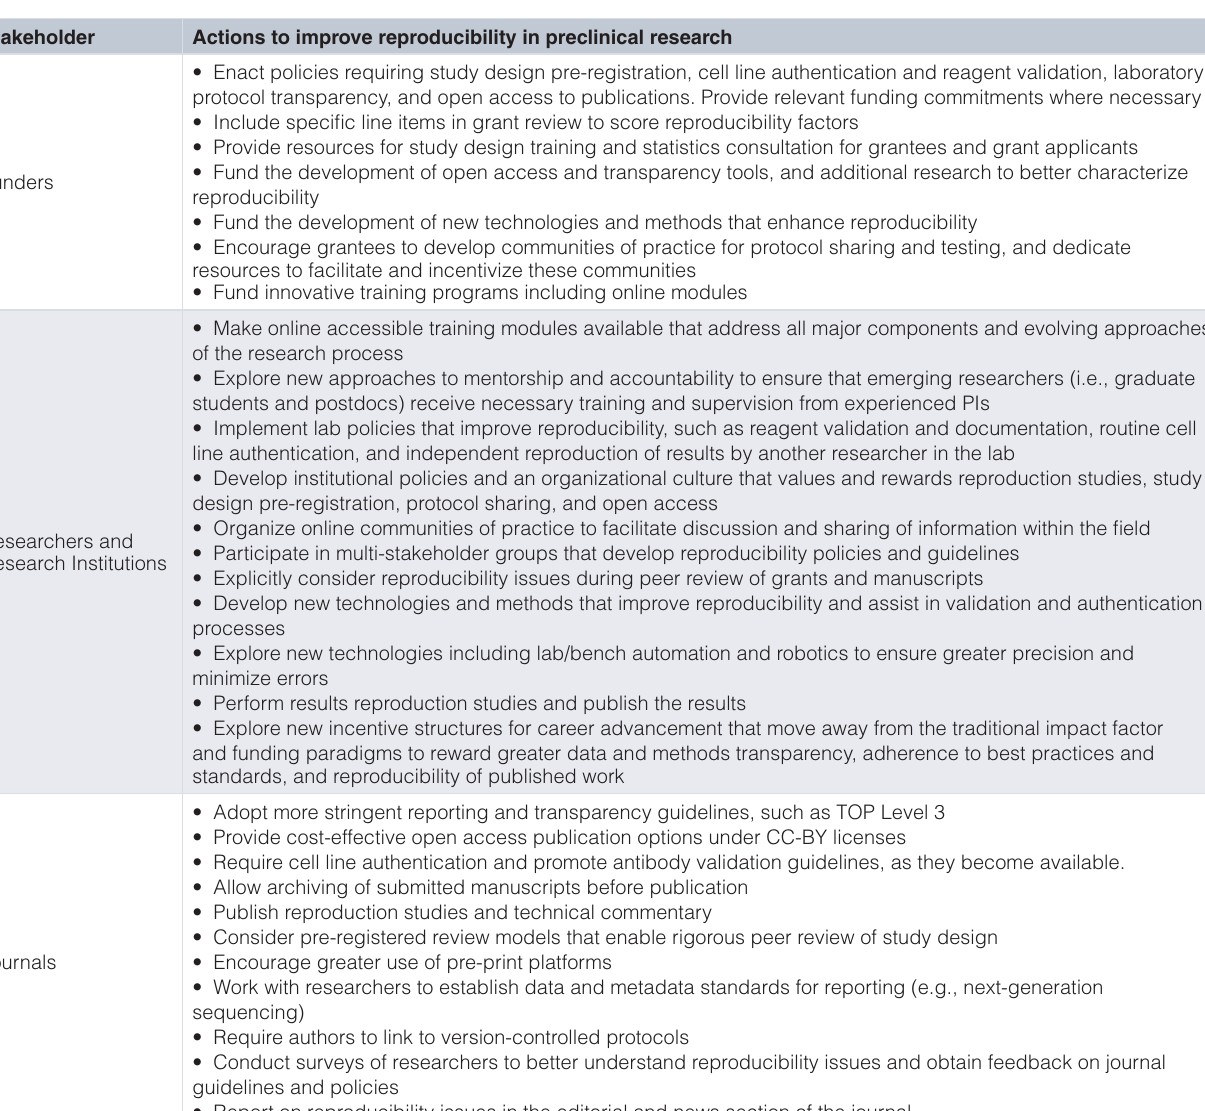
Table 3. Reproducibility2020 action